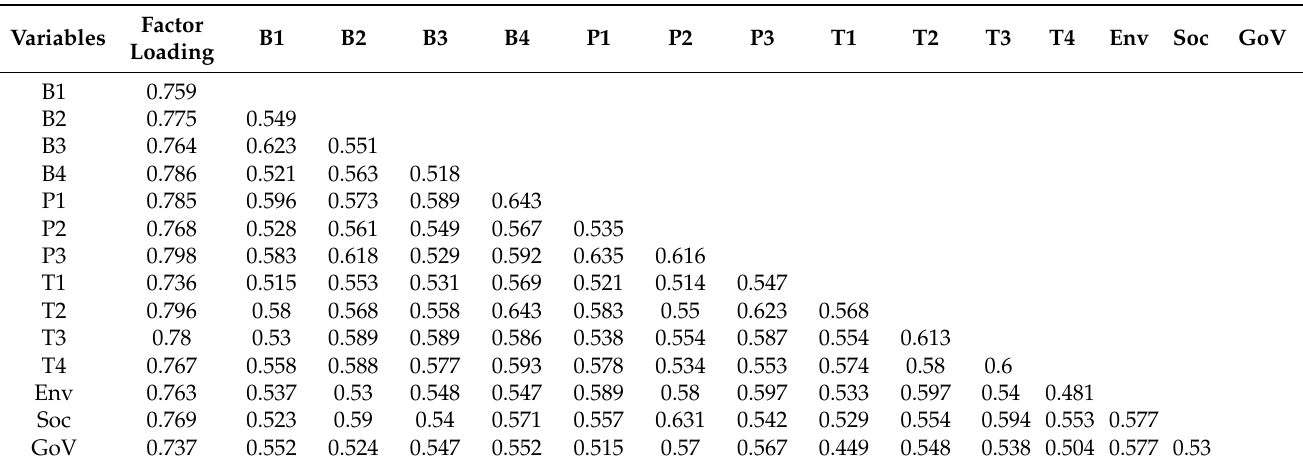
Table A4. The validity statistics with the correlation significance at the 0.01 level (2-tailed).